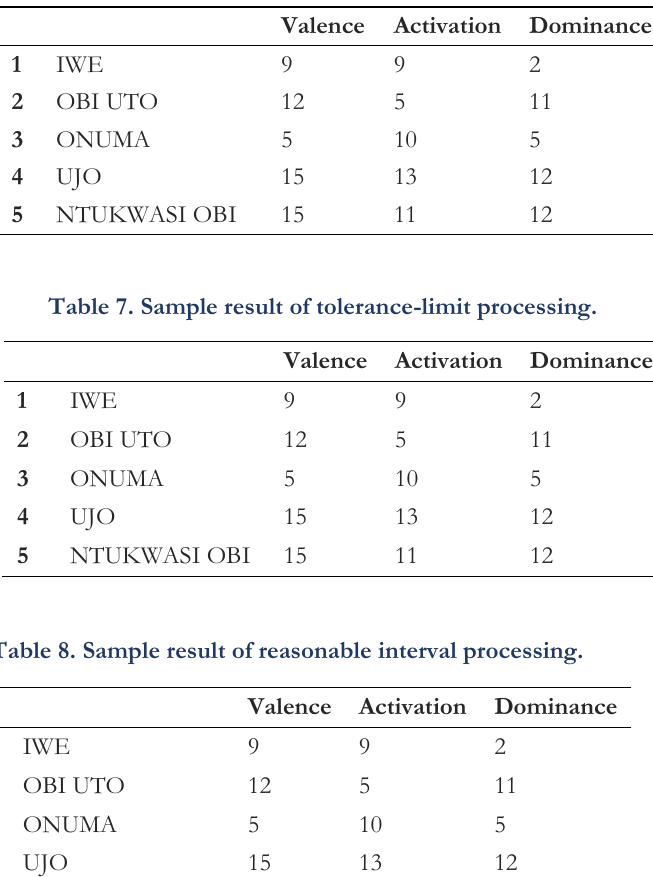
Table 6. Sample result of outlier processing.